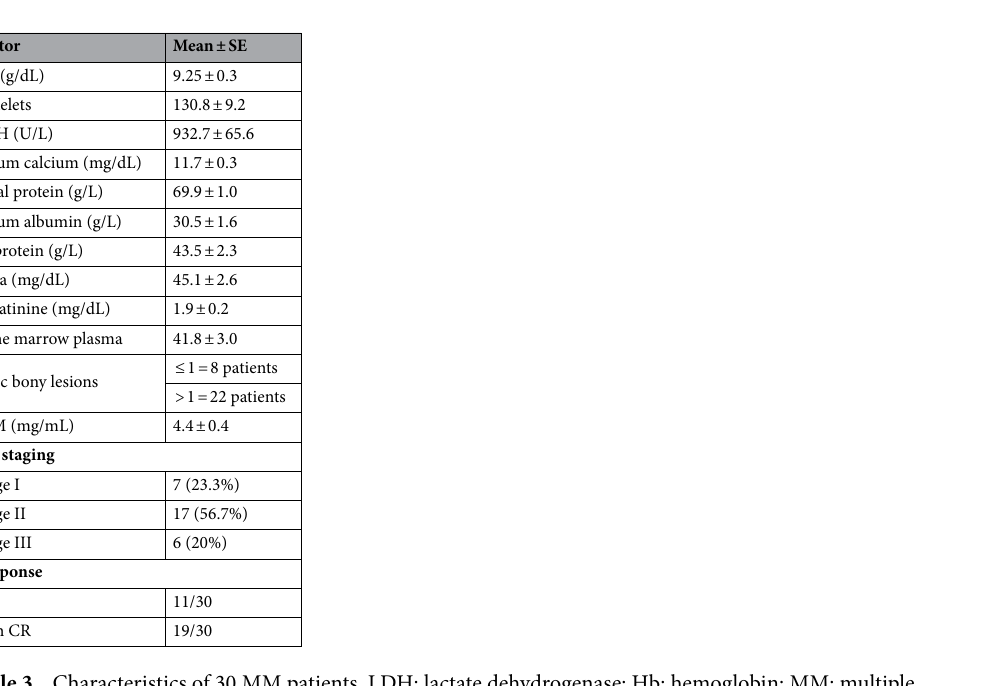
Table 3. Characteristics of 30 MM patients. LDH: lactate dehydrogenase; Hb: hemoglobin; MM: multiple myeloma; β2M: beta2 microglobulin; ISS: international staging system; CR: complete